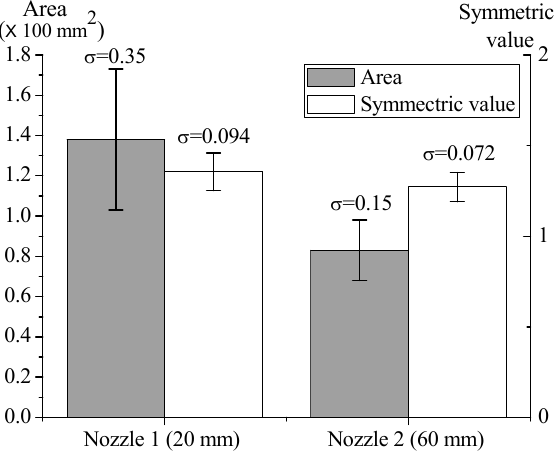
Figure 4. Effects of nozzle length on particle deposition. Data are shown with mean ± SD ( n = 3).